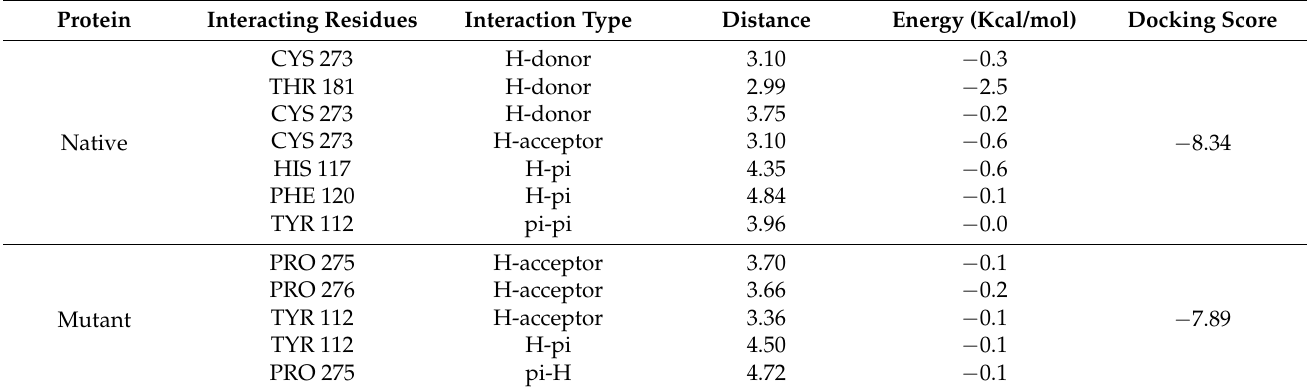
Table 2. Represents the docking scores and reports of predicted interactions of heme toward native and mutant